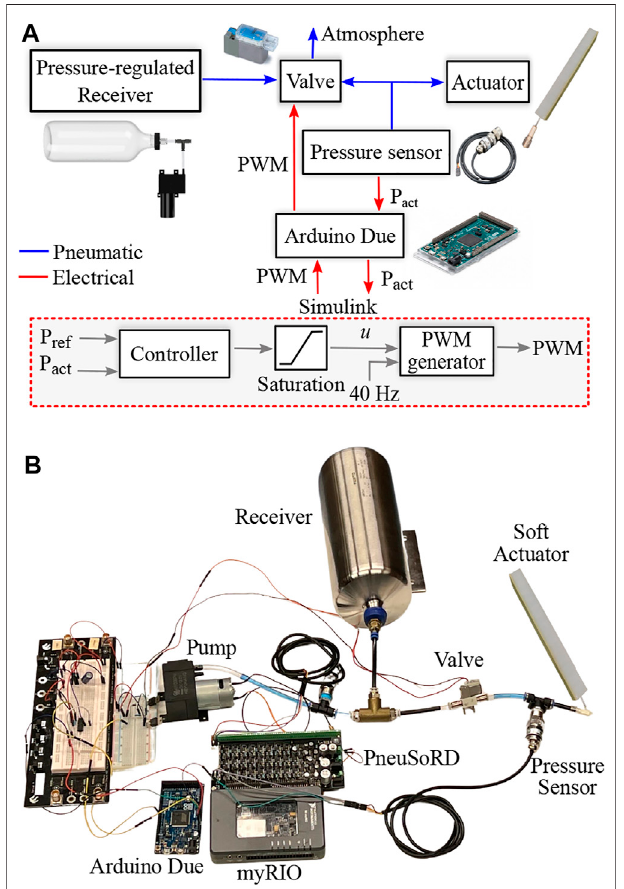
FIGURE 1 | Pneumatic system with 3/2 valve and pressure-regulated receiver. The pressure of the soft actuator is regulated by controlling the duty cycle of the valve with a 40-Hz PWM signal. The dotted red box illustrates the implementation of the control strategies in Simulink. (A) High-level description. (B) Physical